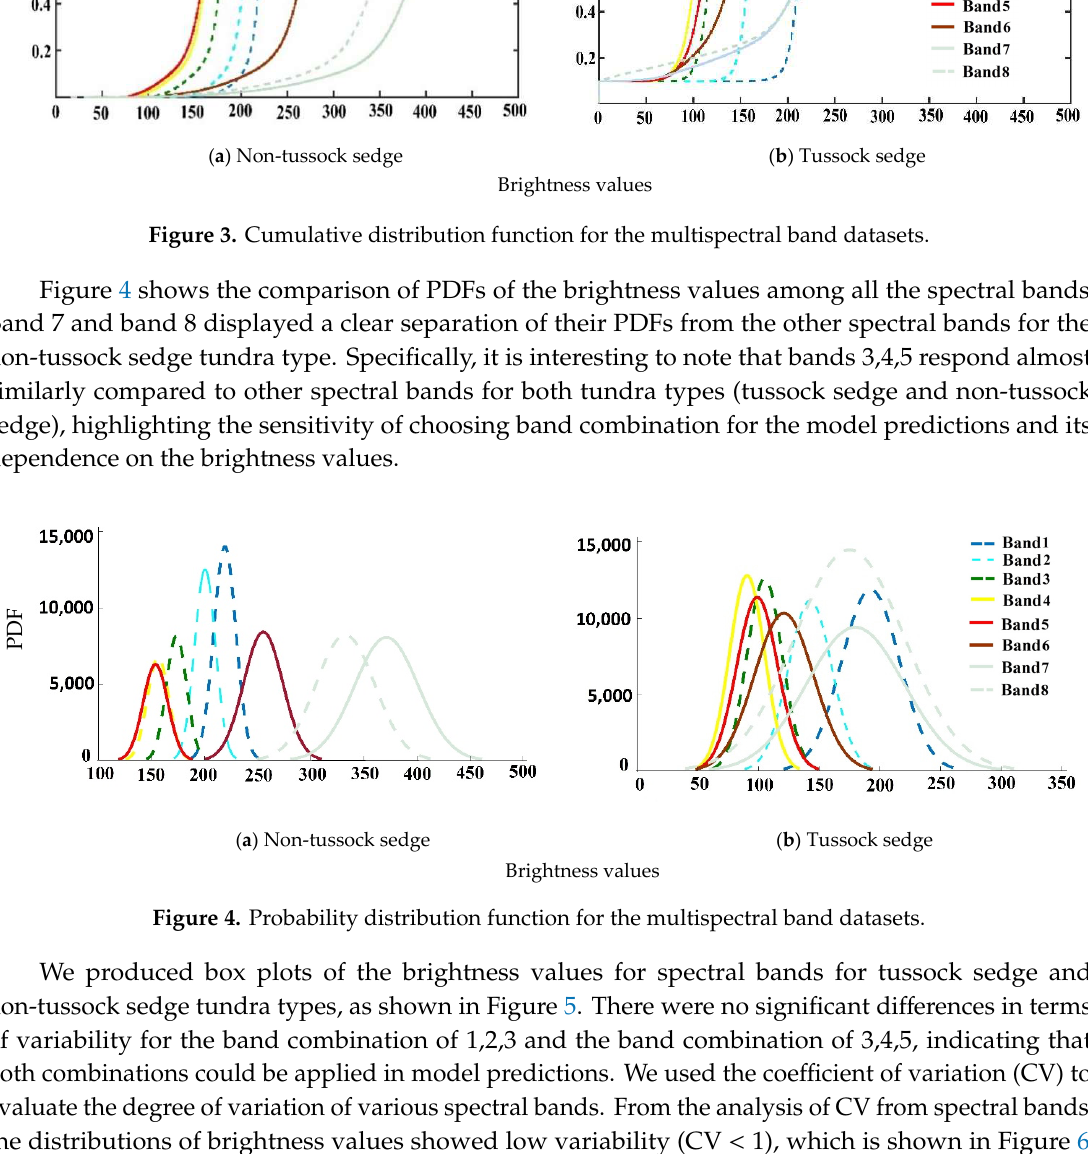
( b ) Tussock sedge Band number Figure 5. Box plot for the multispectral band datasets. In each box, the central mark is the median, and the edges are the first and third quartiles. 4.2. Statistical Measures for Model Prediction We statistically evaluated the performances of the DL model in detecting IWPs. For the quantitative assessments, from each image scene, we randomly selected 15 subsets to manually delineate polygons as a reference (ground-truth polygons). Systematic error was exhibited for all image scenes, and results showed significantly low AMRE values (0.16–0.19) for three-band combinations (1,2,3 and 3,4,5) for the different tundra types (tussock and non-tussock sedge) (Table 1). Other combinations produced comparatively high systematic error (0.33–0.38). The results provide insights on how to select a proper band combination for remote sensing satellite images for deep learning modeling. Similarly, the random error for two band combinations (1,2,3 and 3,4,5) varied from 0.17 to 0.21 for the two candidate scenes (Table 2), indicating a robust performances of